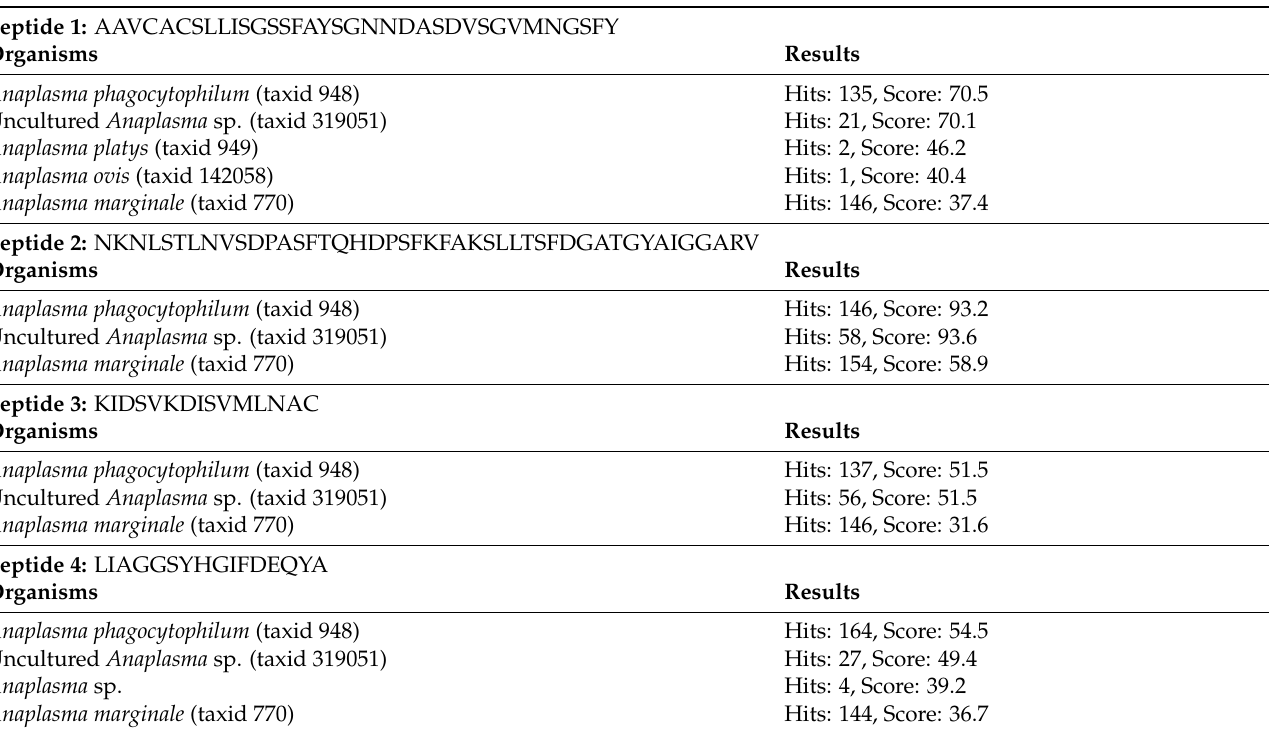
Table 2. Peptide sequence alignment using Blastp showing homologies with different Anaplasma